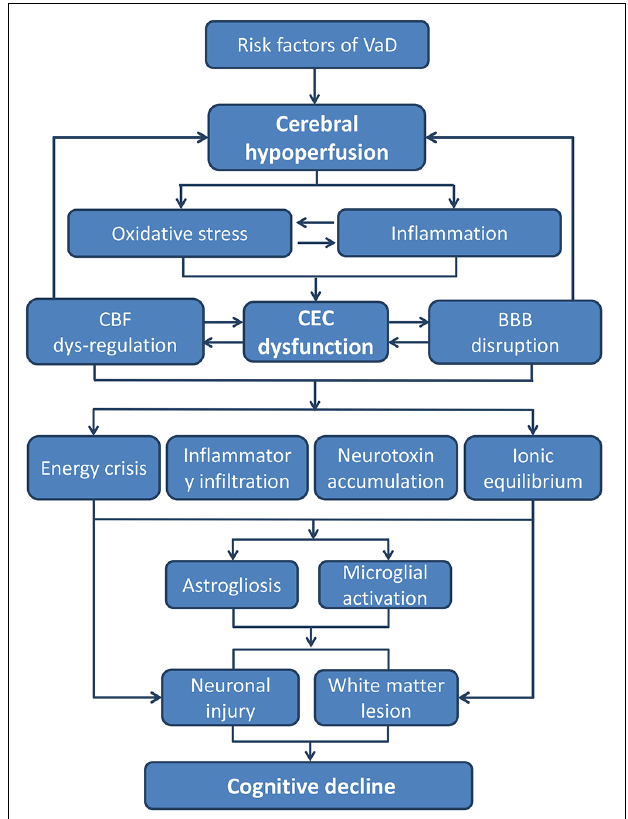
FIGURE 2 | The pathways from CEC dysfunction to cognitive decline. The core pathological characteristics of CEC dysfunction are oxidative stress and inflammatory response, which could be the result of hypoperfusion due to all kinds of VaD risk factors. The two aspects of CEC dysfunction can both lead to a neurotoxic environment for neurons and white matters, whereby cognitive decline and dementia occurs eventually (BBB, blood–brain barrier; CEC, cerebrovascular endothelial cell; CBF, cerebral blood flow; VaD, vascular